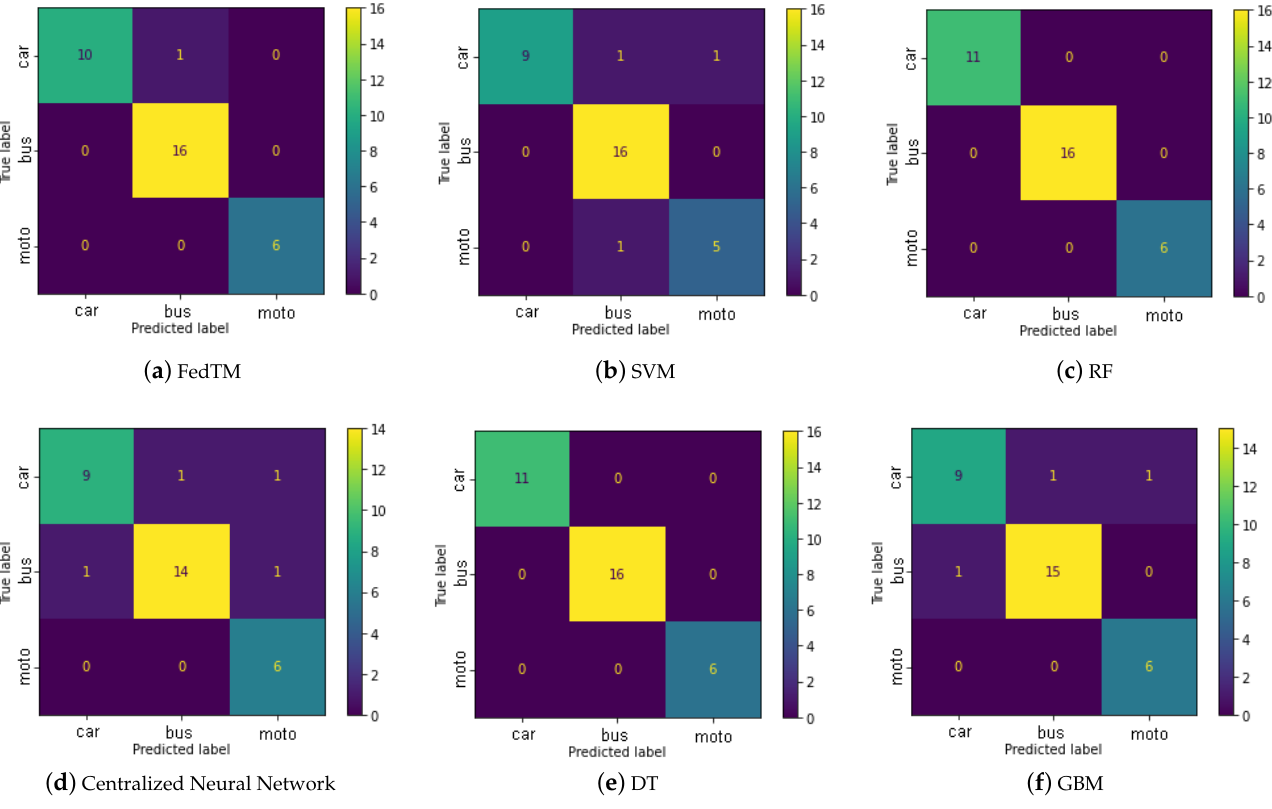
Figure 5. Confusion matrices of the